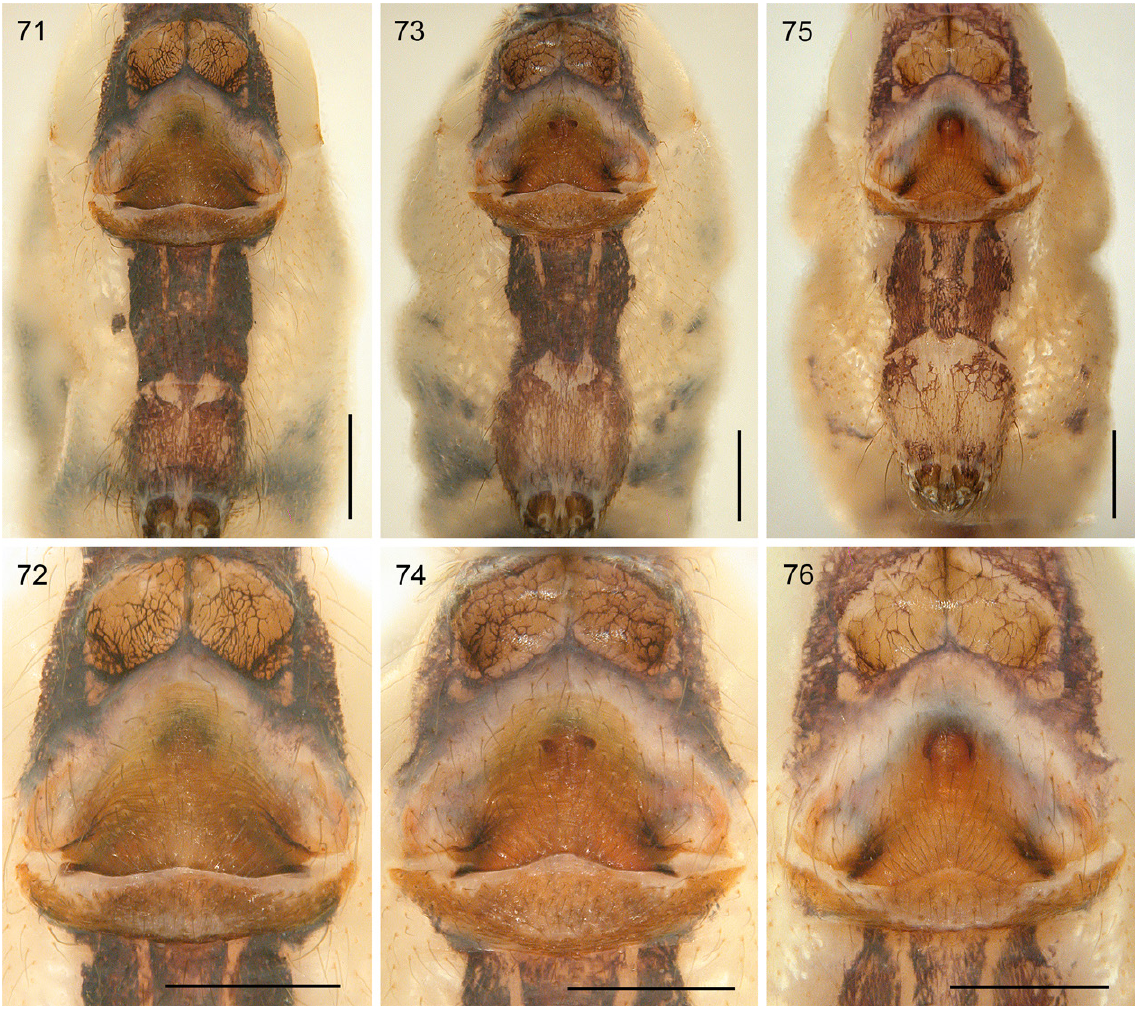
Figs 71–76. Holocnemus reini (C. Koch, 1873) comb. nov.; female abdomens and epigyna, ventral views. 71–72 . Morocco, SW of Bab Boudir (ZFMK Ar 22346). 73–74 . Morocco, near El Ksiba, Kehf d’bouba (ZFMK Ar 22336). 75–76 . Morocco, W of Tamtetoucht (ZFMK Ar 22341). Scale bars = 0.5